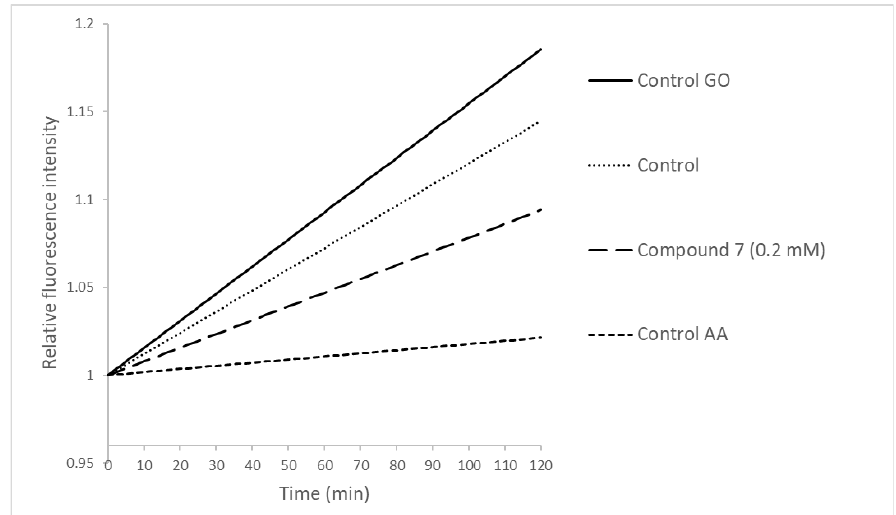
Figure 5. Effect of compound 7 on the oxygen consumption rate measured by MitoXpress fluores- cence. “ Control GO ” corresponds to samples without conidia and glucose oxidase enzyme as the positive control. “ Control AA ” corresponds to conidia treated with antimycin A (a respiratory chain inhibitor). Control corresponds to conidia without any treatment. Two independent assays were done. Each assay was done in triplicate.